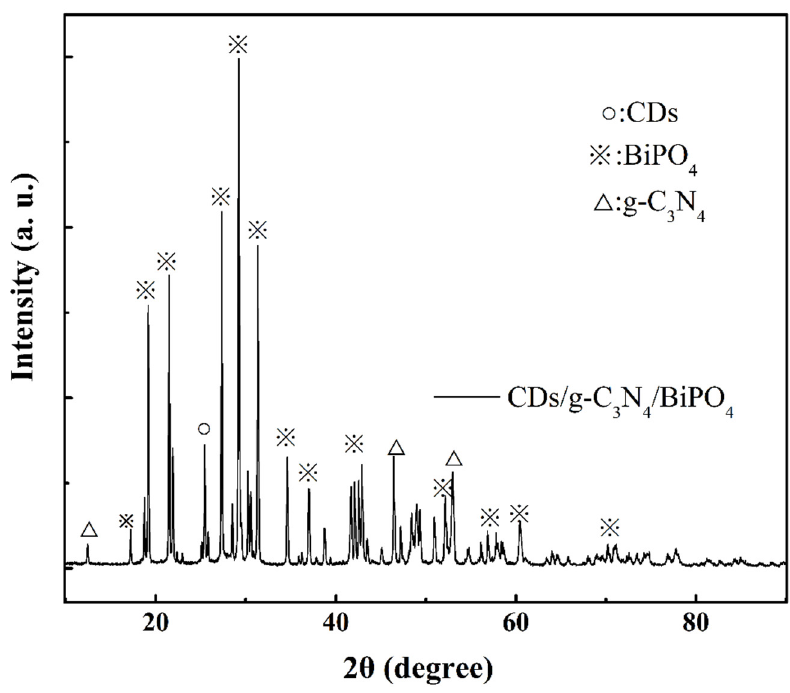
Figure 3. XRD patterns of CDBPC.